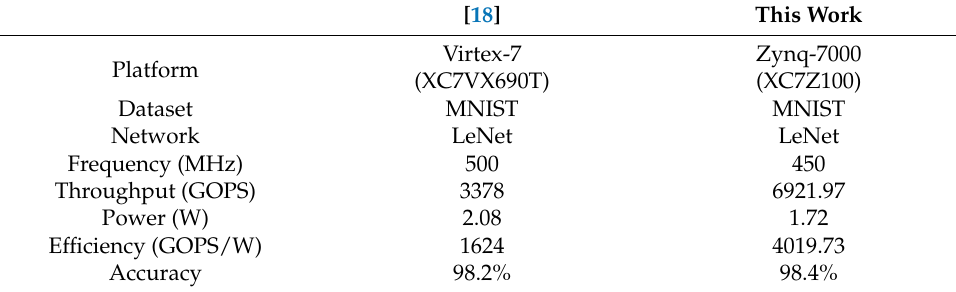
Table 1. Comparisons with other designs on MNIST